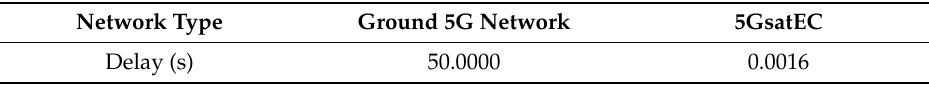
Table 3. Delay between ground 5G network and 5GsatEC.